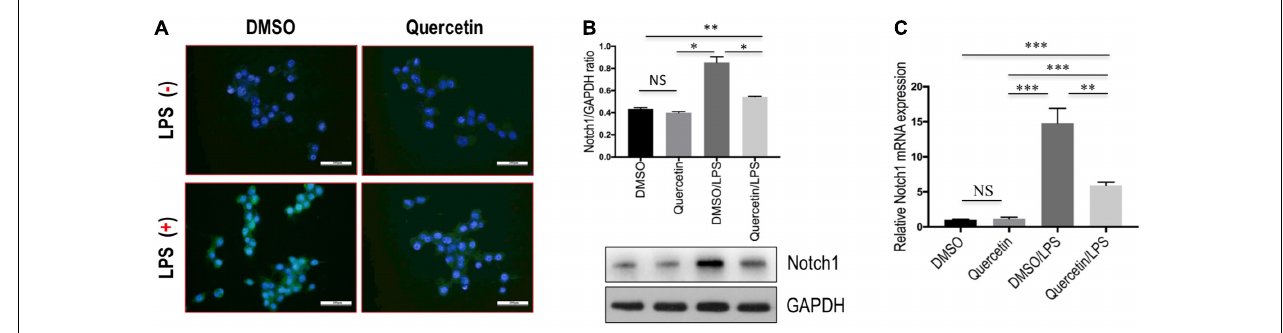
FIGURE 9 | Quercetin inhibited M1-macrophages polarization through regulating the expression Notch1 on macrophages in vitro . (A) Undifferentiated RAW 264.7 macrophages conditioned medium or LPS-stimulated M1-differentiated macrophages, quercetin (50 µ M)-treated RAW macrophages, DMSO as vehicle-treated control. Scale bar = 200 µ m. (B) Western blotting analysis for Notch1 in RAW 264.7 cells. (C) The levels of Notch1 mRNA expression in RAW 264.7 cells were measured by quantitative RT-PCR. The mRNA levels were normalized to GAPDH mRNA levels and presented as fold stimulation (mean ± SD ) versus DMSO. ∗ P < 0.05; ∗∗ P < 0.01; ∗∗∗ P < 0.001; “NS” indicates not